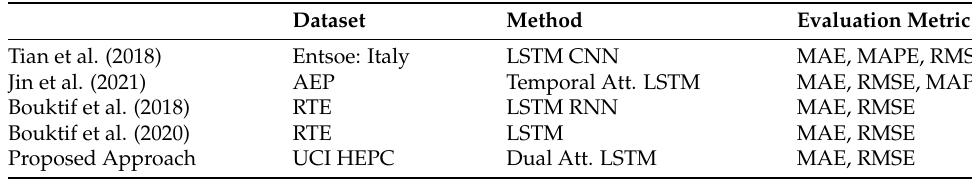
Table 1. Related work